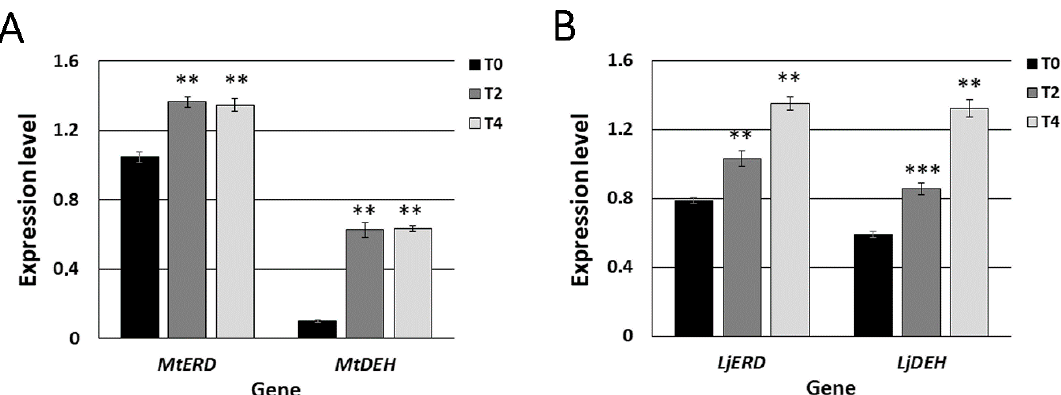
Figure 2. Normalised expression levels of drought stress marker genes in M. truncatula ( A ) and L. japonicus ( B ) root nodules harvested from plants grown in control conditions (T0) and after two (T2) and four (T4) days without watering. Mean values (±SE) are derived from two biological replicates, for which three individual qPCR reactions were performed ( n = 6). Asterisks above the bars represent statistically significant differences at the level p < 0.01 (**) or p < 0.001(***).